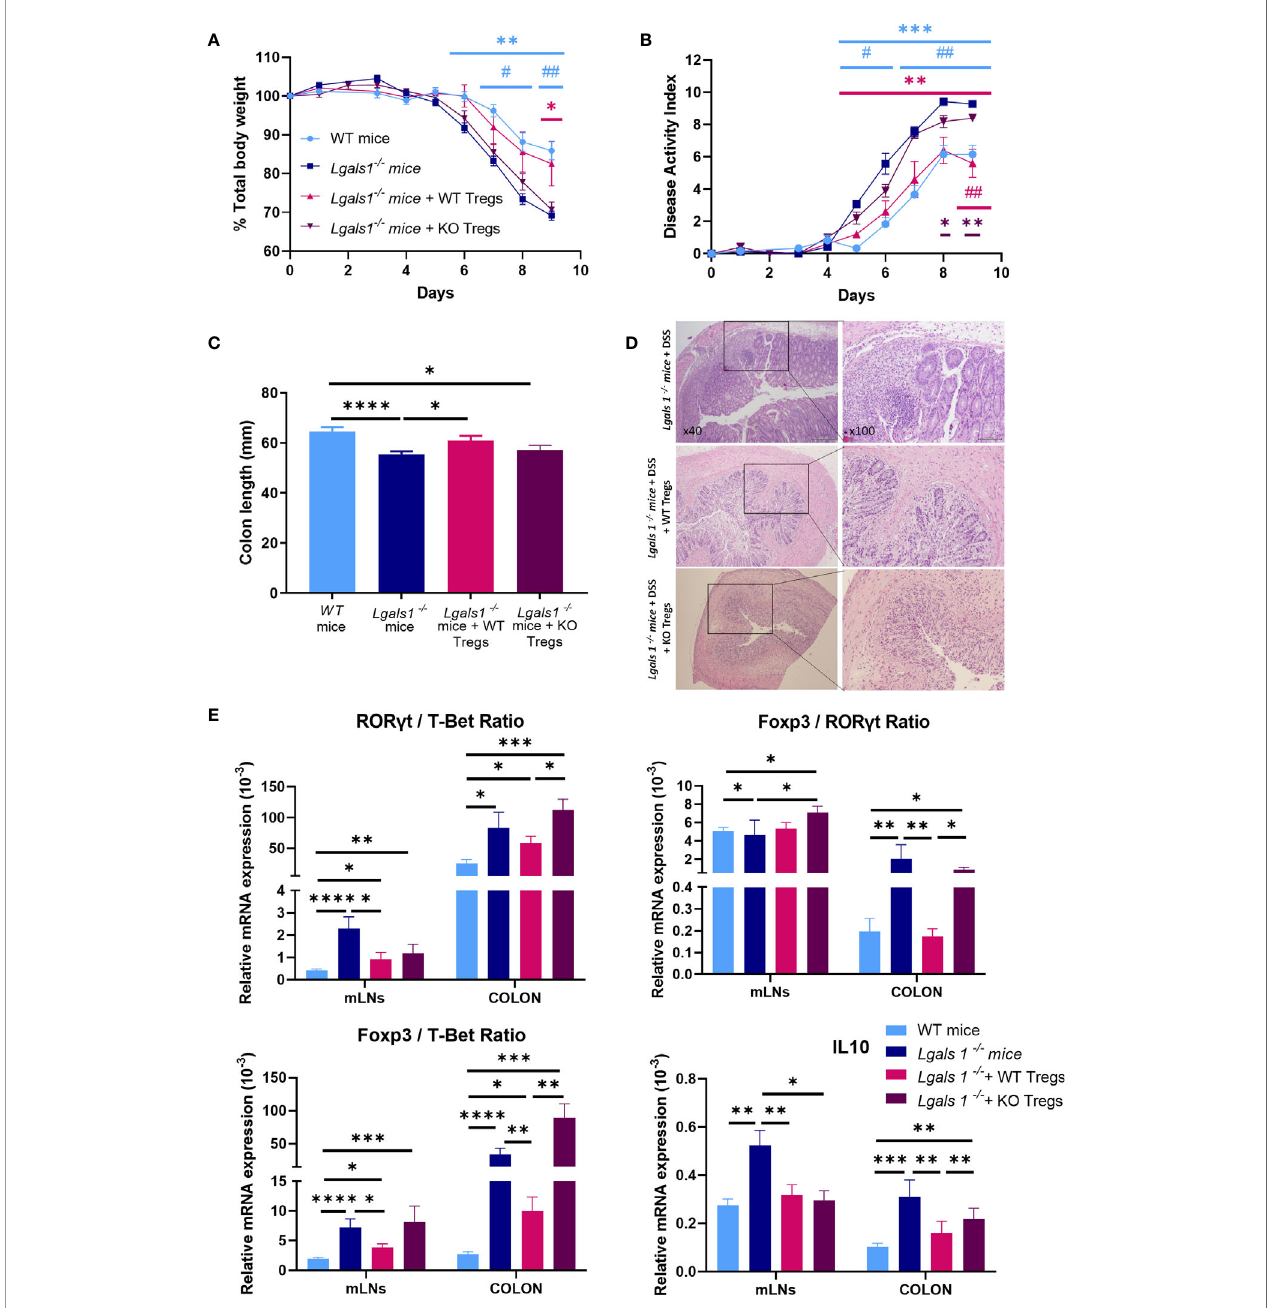
FIGURE 6 | Adoptive transfer of wild type CD25 high CD127 low/ − Foxp3 + CD4 + Treg cells ameliorated clinical signs of DSS-induced colitis in DSS-treated Foxp3 EGFP+ Lgals1 − / − mice. Colitis was induced with 1.25% DSS w/v in drinking water for 7 days ad libitum and mice were monitored daily. (A) Total body weights. (B) Disease activity index (n = 6 for WT, n = 7 Lgals1 − / − , n = 5 for Lgals1 − / − with WT/Tregs and n = 5 for Lgals1 − / − with KO/Tregs mice per group). In statistical analysis, *corresponds to the signi fi cant differences with respect to Lgals1 − / − mice and # with signi fi cant differences with respect to KO/Tregs treated colitic Lgals1 − / − mice. (C) Colon lengths (n = 24 for WT, n = 25 for Lgals1 − / − , n = 11 for Lgals1 − / − transferred with WT/Tregs and n = 5 for Lgals1 − / − transferred with KO/Tregs mice per group). (D) Representative H&E colon tissue of colitic Lgals1 − / − mice, colitic Lgals1 − / − mice infused with 1 × 10 6 WT/Treg cells and colitic Lgals1 − / − mice infused with 1 × 10 6 KO/Treg cells respectively (×40 left, ×100 right magni fi cations). mRNA expression of ROR g t, T-Bet, Foxp3 and IL-10 were measured in mLNs and colon of colitic wild type, Lgals1 − / − , WT/Tregs infused Lgals1 − / − mice and KO/Tregs infused Lgals1 − / − mice (n = 11 for WT, n = 10 for Lgals1 − / − , n = 10 for Lgals1 − / − with WT/Tregs and n = 5 for Lgals1 − / − with KO/Tregs mice per group). (E) ROR g t/T-Bet ratio, Foxp3/ROR g t ratio, Foxp3/T-Bet ratio and IL-10 mRNA expression. Data are representative of two independent experiments. Statistical analysis was done using Mann – Whitney U test. Data are shown as mean ± SEM, *p < 0.05 ; **p < 0.01 ; ***p < 0.001 ; ****p < 0.0001; # p > 0.05, and ## p >